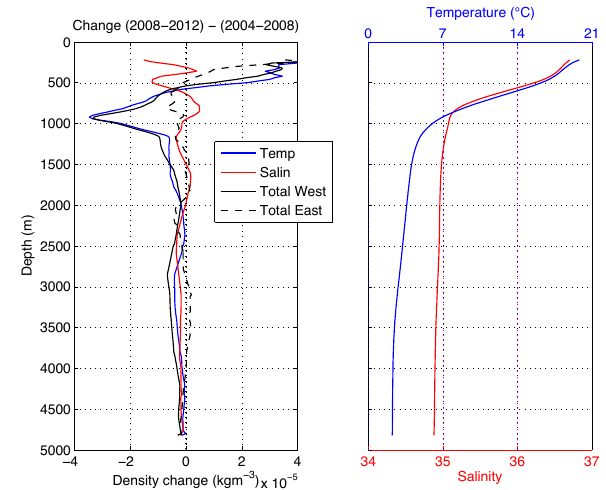
Fig. 5. Time series of the upper NADW (top) and lower NADW (bottom). Values are anomalies relative to mean annual cycle (pos- itive is northward). A 45-day low-pass filter was applied to each time series. For each time series horizontal dashed lines show ± two standard deviations and the solid black lines show the average trend ± 1.64 standard errors (i.e. 90% confidence limits).